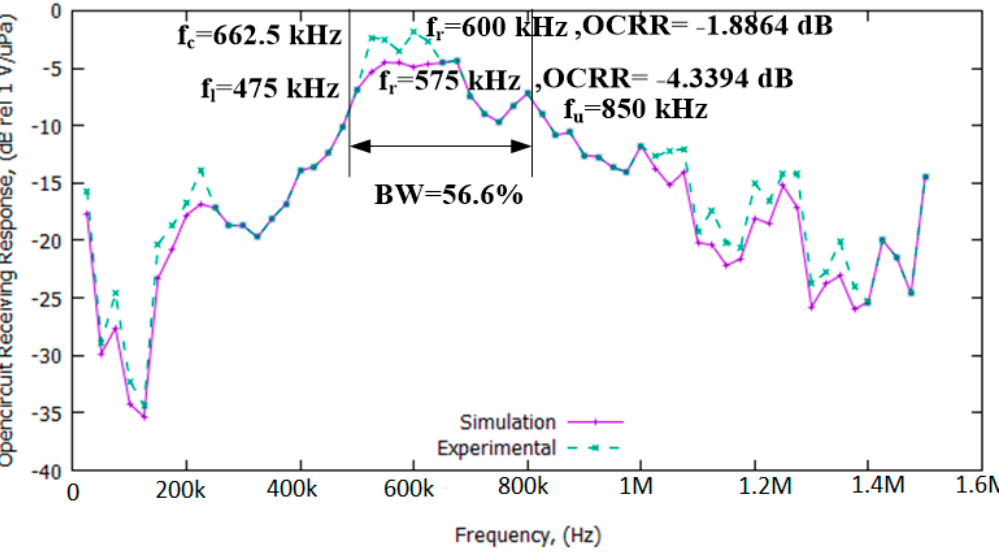
Figure 9. Open-circuit receiving responses for the proposed double-membrane device (simulated and experimental results).